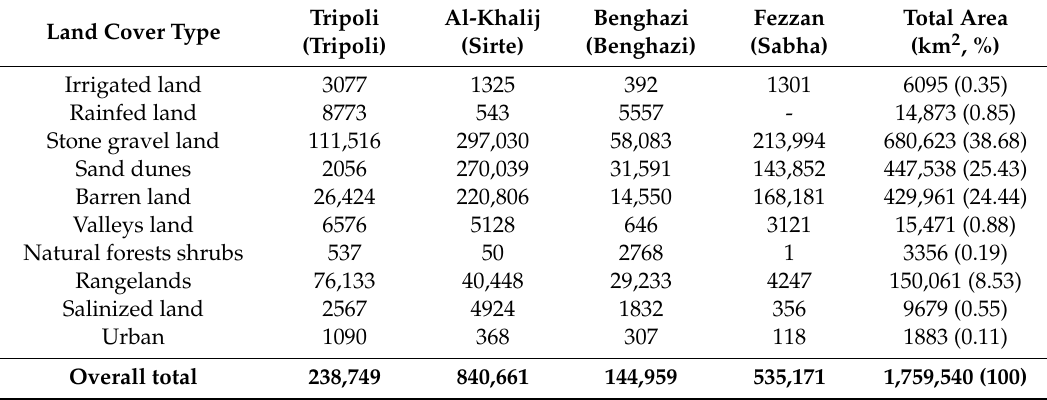
Table 13. Land cover type areas (km 2 ) territory based on [13].